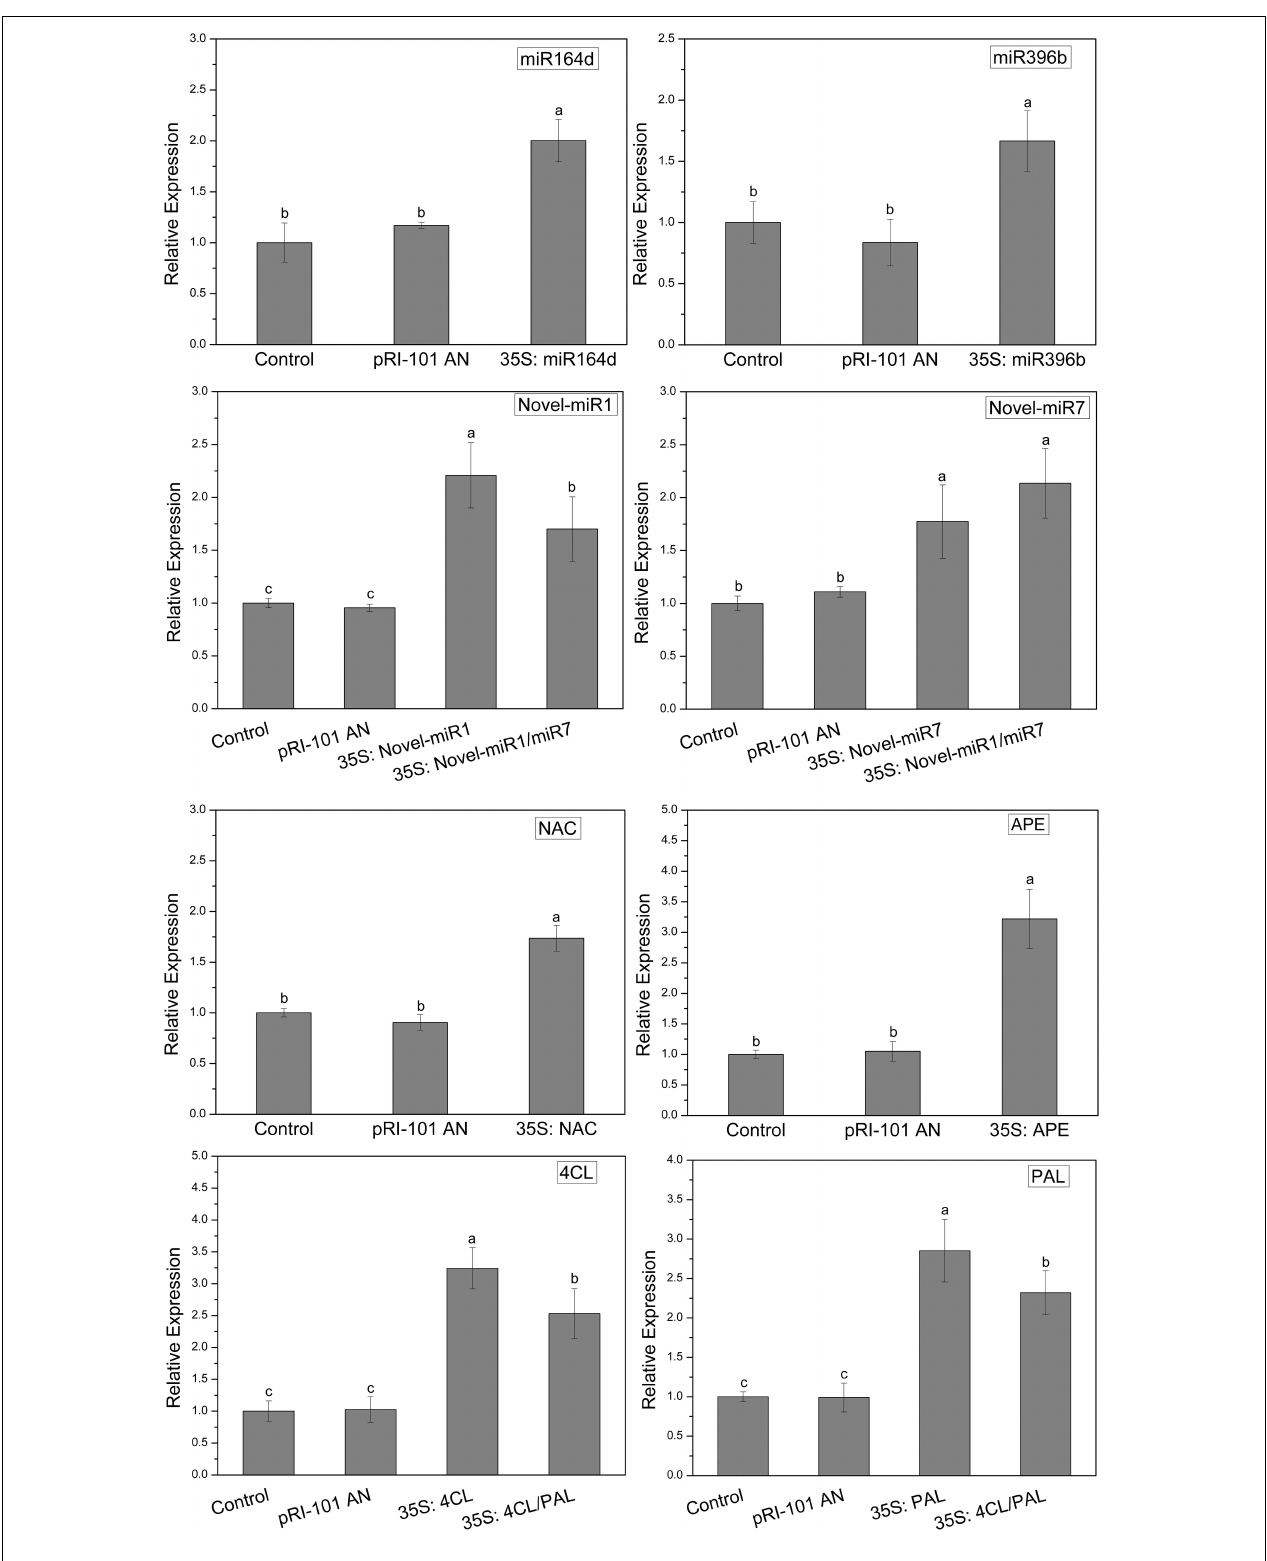
FIGURE 3 | Transient expression levels of miRNAs and target genes in cucumber cotyledons. Significance was determined by Duncan’s multiple range test ( P < 0.05).